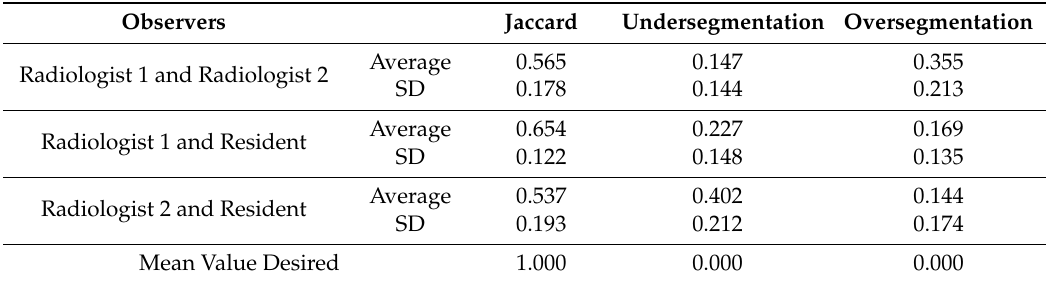
Table 2. Measures to evaluate the manual delineation.